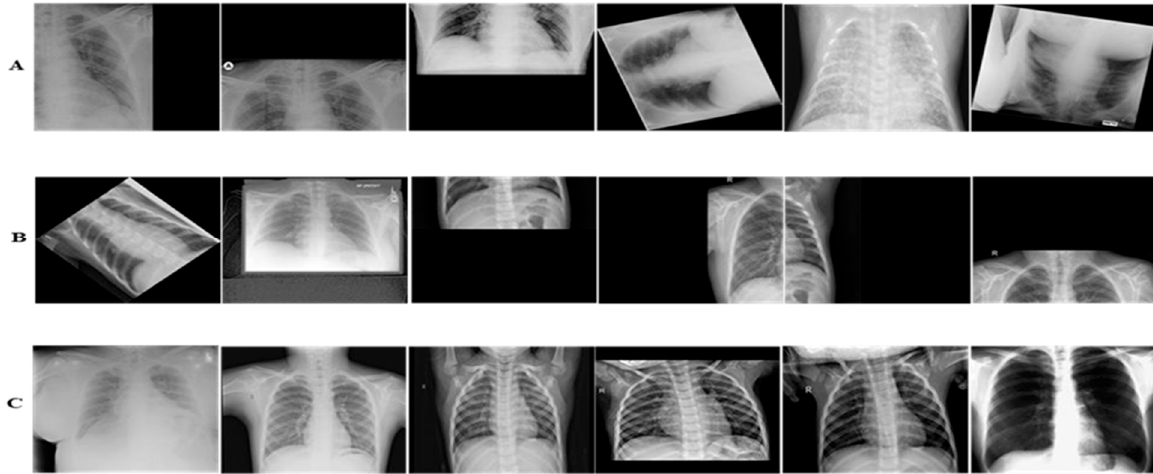
Figure 6. Panel ( A – C ) illustrate COVID-19, Non-COVID-19, and Healthy Chest X-ray images, respectively. The images are tough to classify because of having high illumination, translational, rotational, occlusion and missing informational effects.